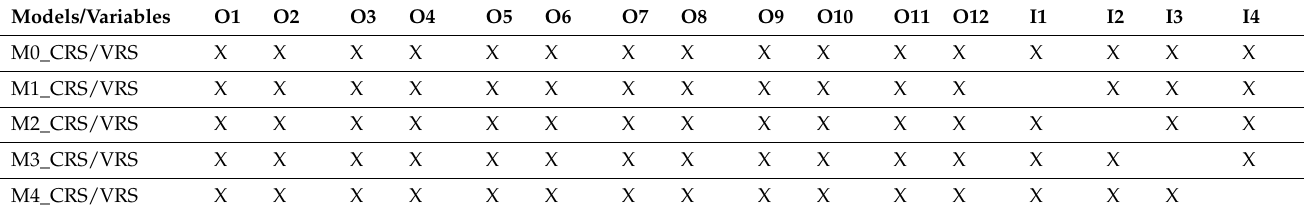
Table 5. Different